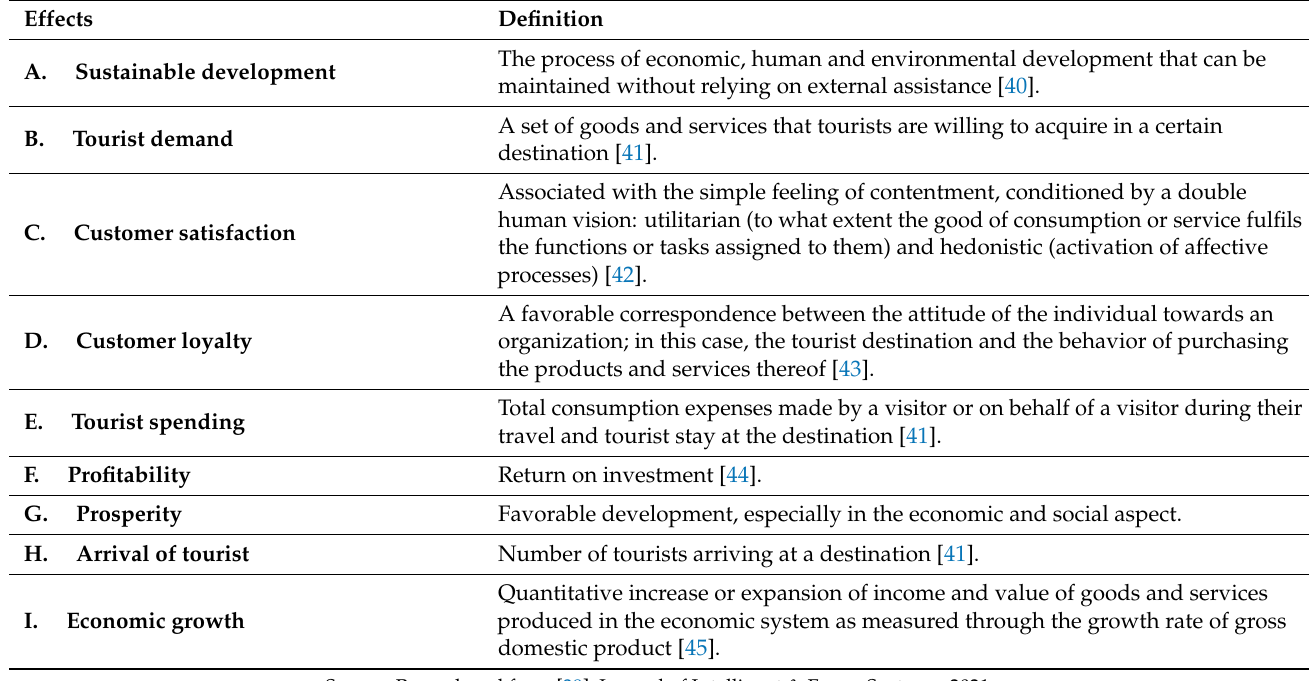
Table 2. Effects of tourist competitiveness.